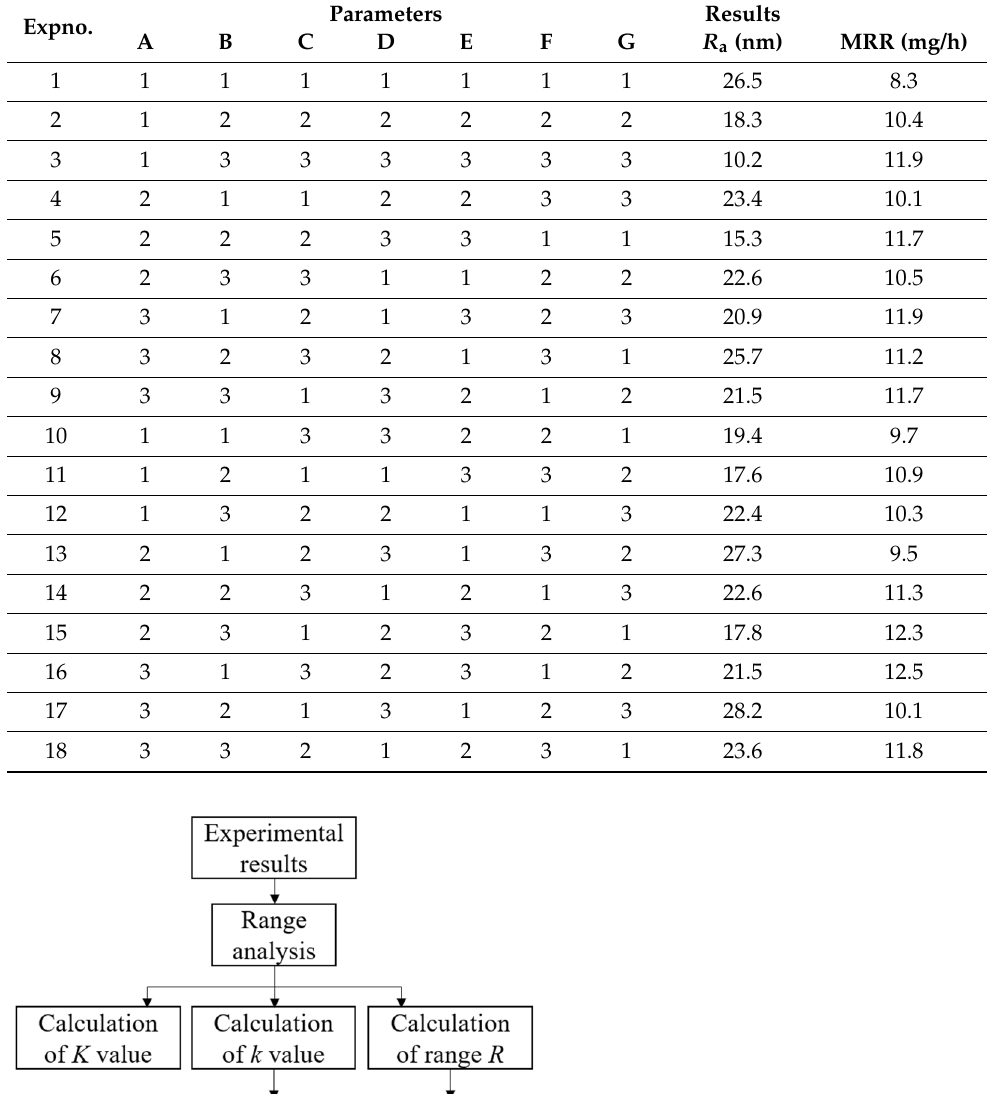
Table 2. Experimental results ( R a and MRR).